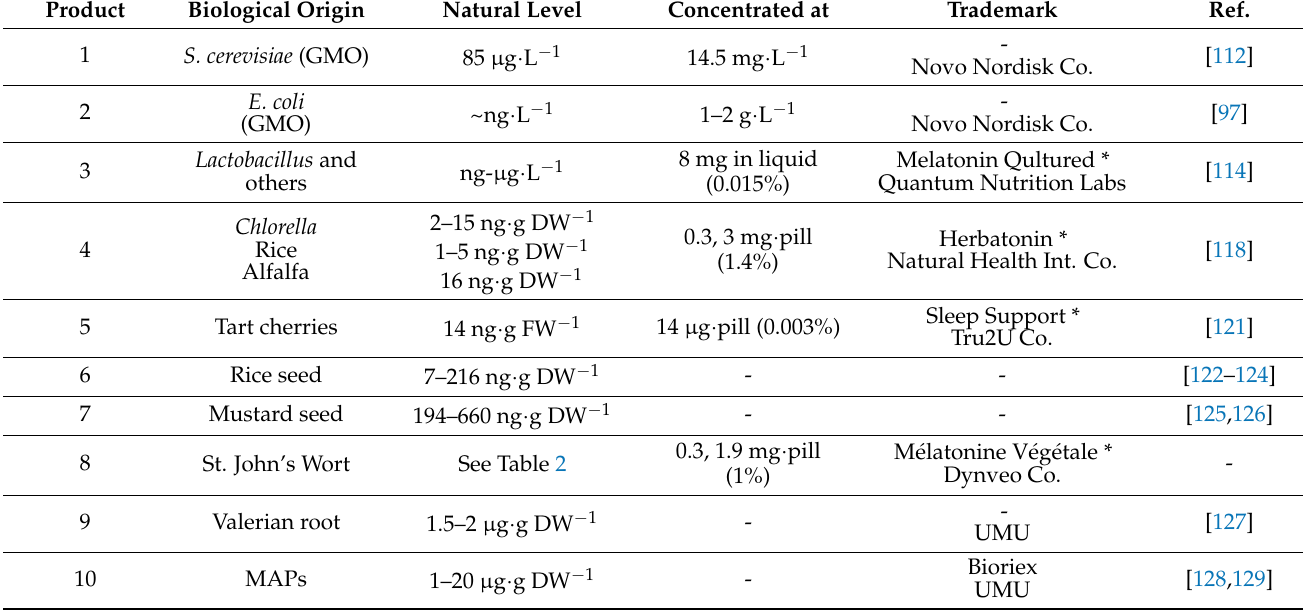
Table 1. Most relevant biological melatonin products from microorganisms and plants and their trademarks or